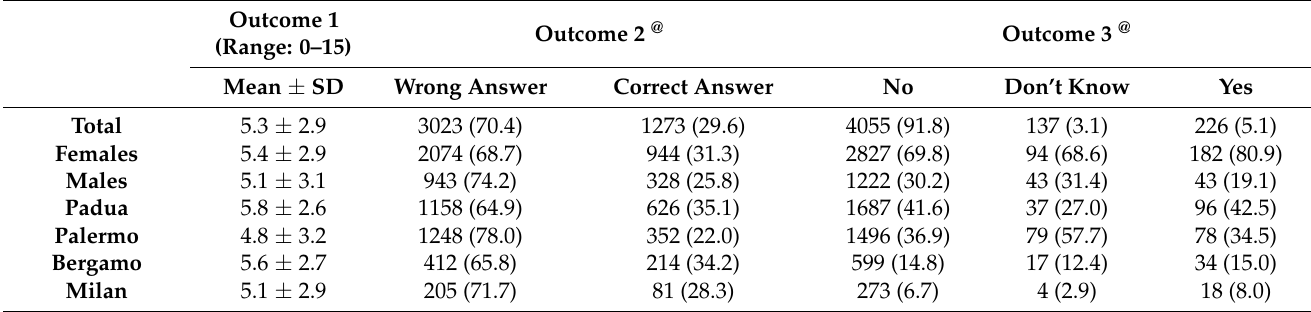
Table 5. Outcome 1 (mean ± standard deviation, SD), outcome 2 (number and row percentage of wrong and correct answer), and outcome 3 (number and row percentage of the three answers to the question on whether students had ever contracted a STI) in the whole population and, separately, by sex and university campus.